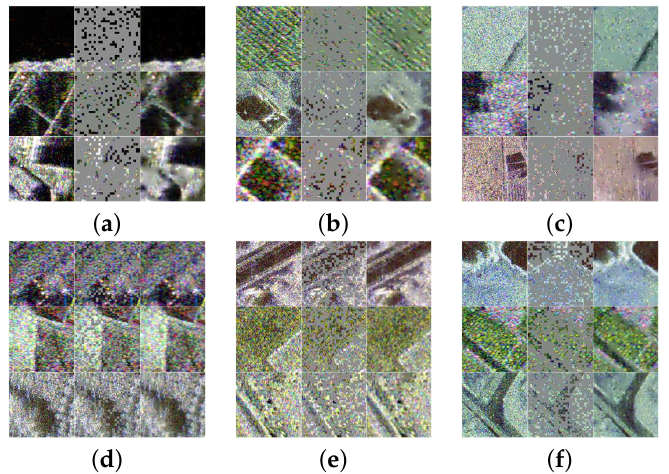
Figure 8. The reconstructed images of the pre-training models, with no pixel normalization. The left, middle, and right columns are the original image, the masked image, and the reconstructed image, respectively. ( a ) Mask ratio = 80, Depth = 1. ( b ) Mask ratio = 80, Depth = 4. ( c ) Mask ratio = 80, Depth = 7. ( d ) Mask ratio = 20, Depth = 4. ( e ) Mask ratio = 40, Depth = 4. ( f ) Mask ratio = 60, Depth =